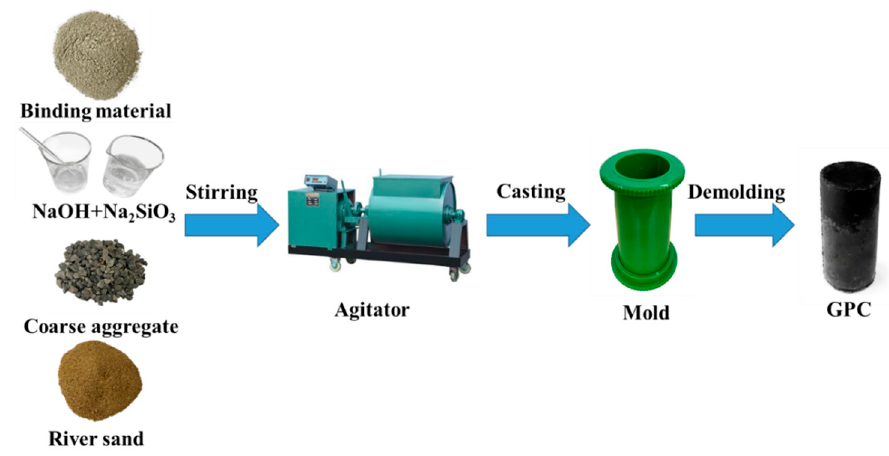
Figure 1. Preparation diagram of GPC.